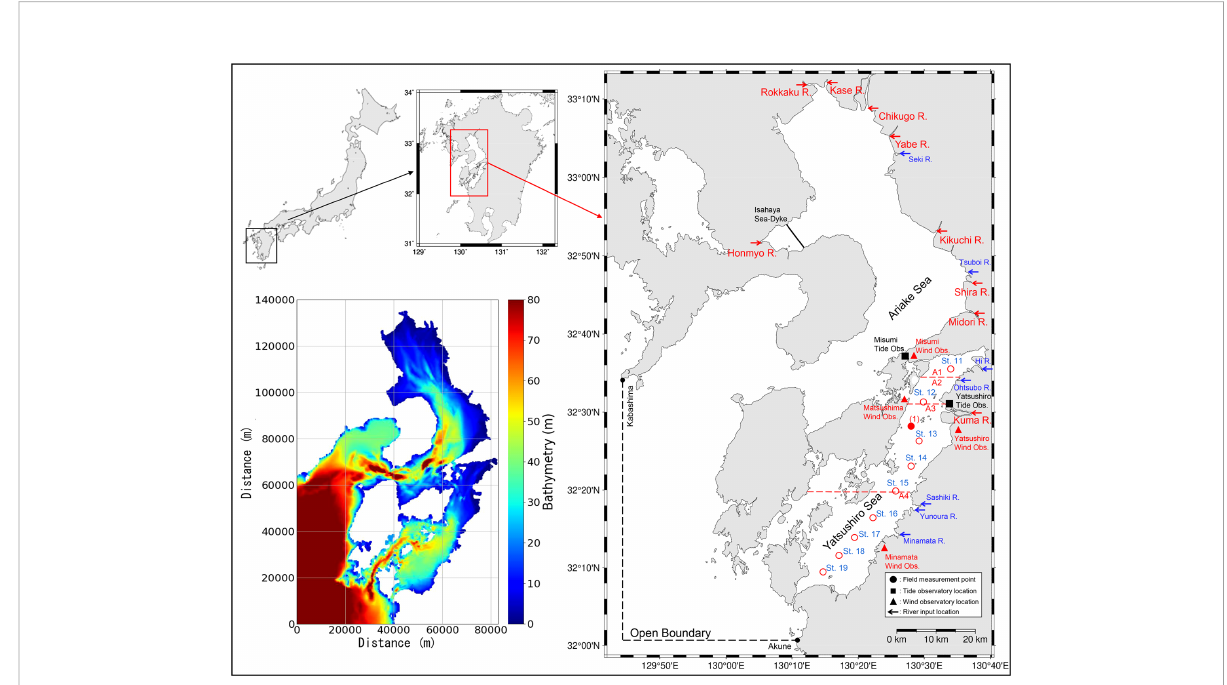
FIGURE 2 The location of the study site (right) and the domain of the numerical model (bottom left). The fi eld measurement points are shown in the map on the right ((1) is the location of the fi eld measurement we conducted, while St.11 to St.19 are the measurement locations of the data from MLIT), schematic diagram of the Yatsushiro Sea subdivision (A1 to A4 separated by red lines) and the location of the wind observatories (red